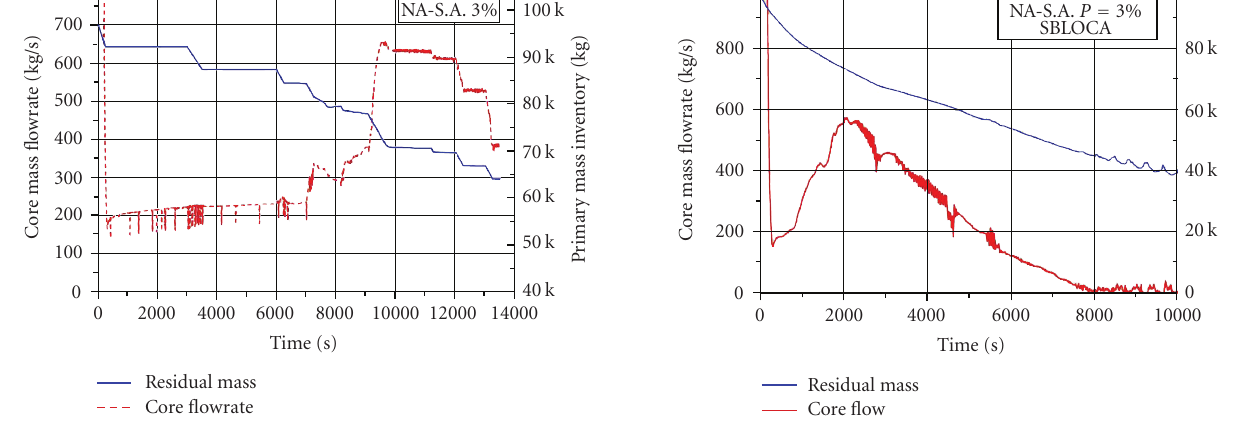
Figure 6: CMFR in a very small SBLOCA, P =